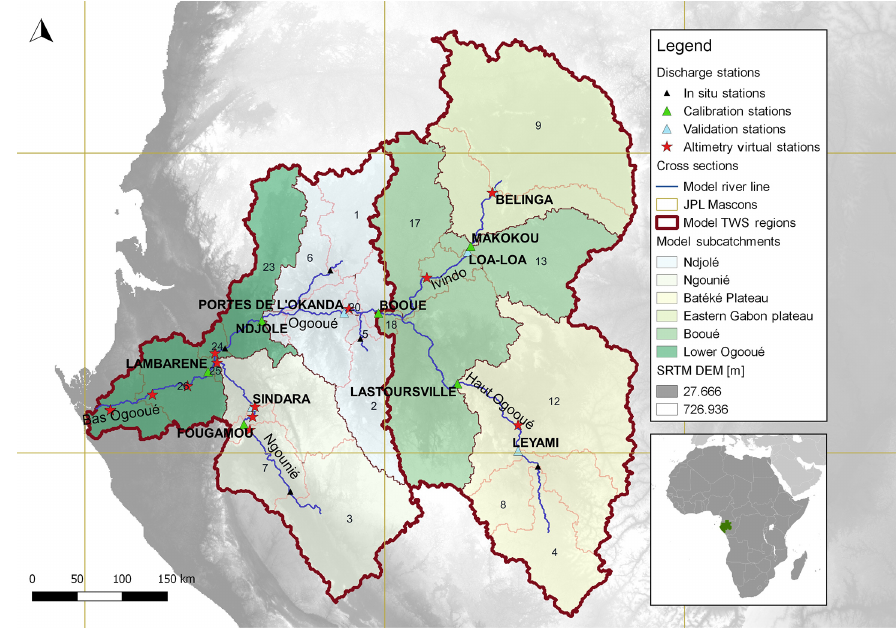
Figure 1. Basemap of the hydrological model of the Ogooué basin along with in situ discharge stations and altimetry virtual